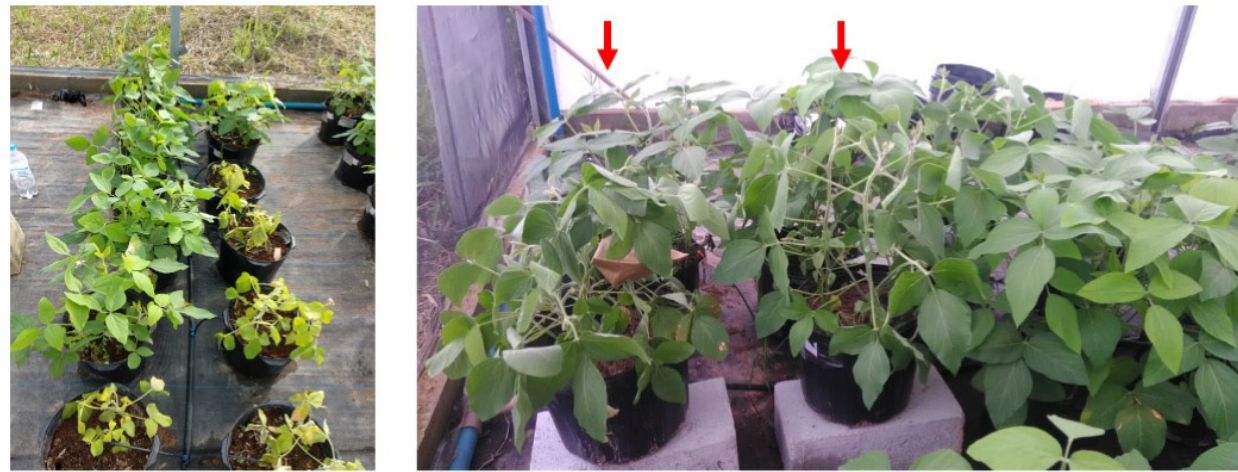
Figure 2. Soybean samples under herbicide and drought conditions. The left picture shows herbicide-treated (i.e. chlorosis symptoms) and untreated soybean plants (i.e. healthy plants). The right picture shows side-by-side soybean samples under drought stress at V5 stage with dehydration symptoms (red arrows) and control plants (optimal water conditions).